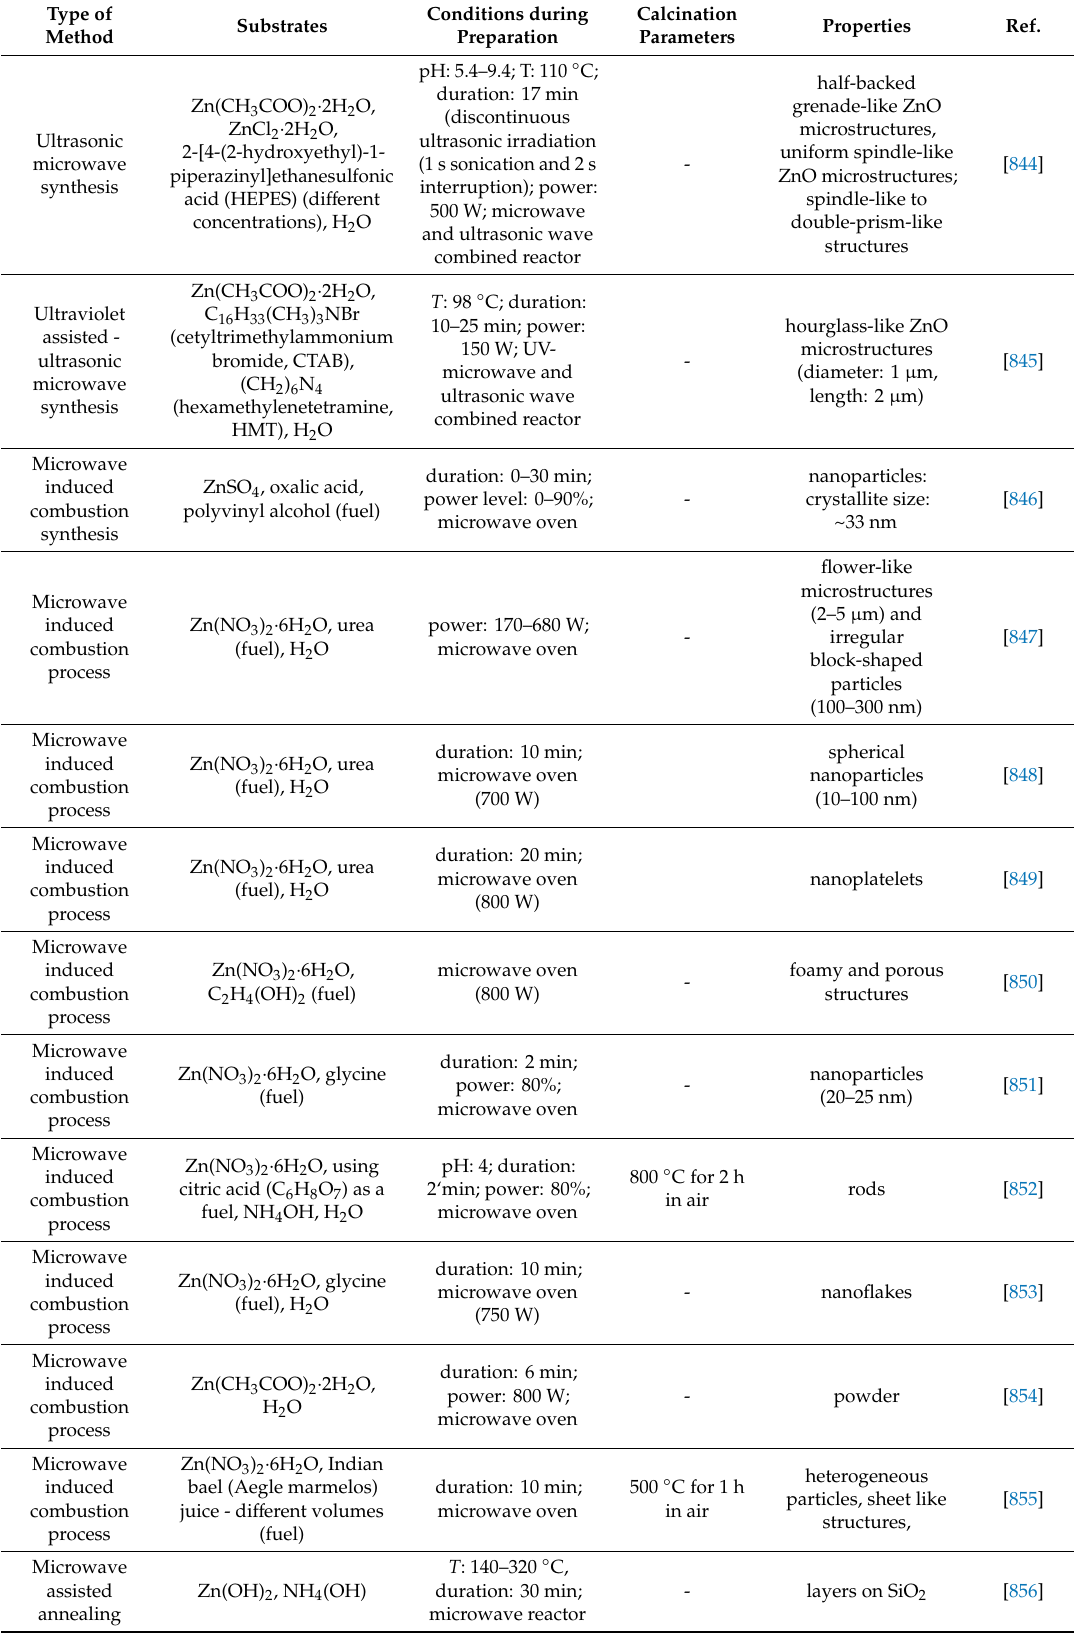
Table 13. Summary of synthesis of pure ZnO by the microwave hybrid